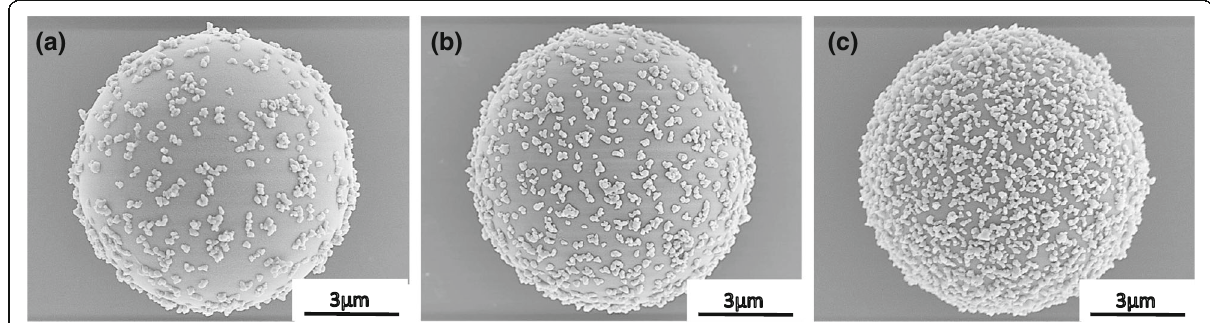
Fig. 4 SEM images of the Al 2 O 3 -SiO 2 composite particles with different coverage of a 25, b 50, and c 75%,